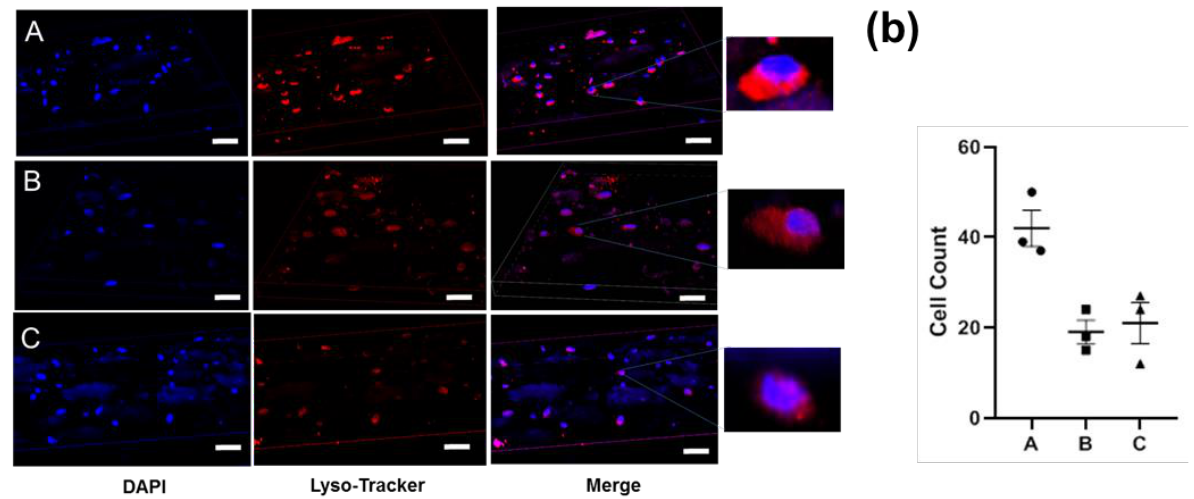
Figure 7 . Images of 3D NIH-3T3 cell cultures in different gels in vitro (72 h). ( a ) The cells were stained with DAPI (blue) and lysosome tracker (red). ( b ) The cell count determination in each visual field.